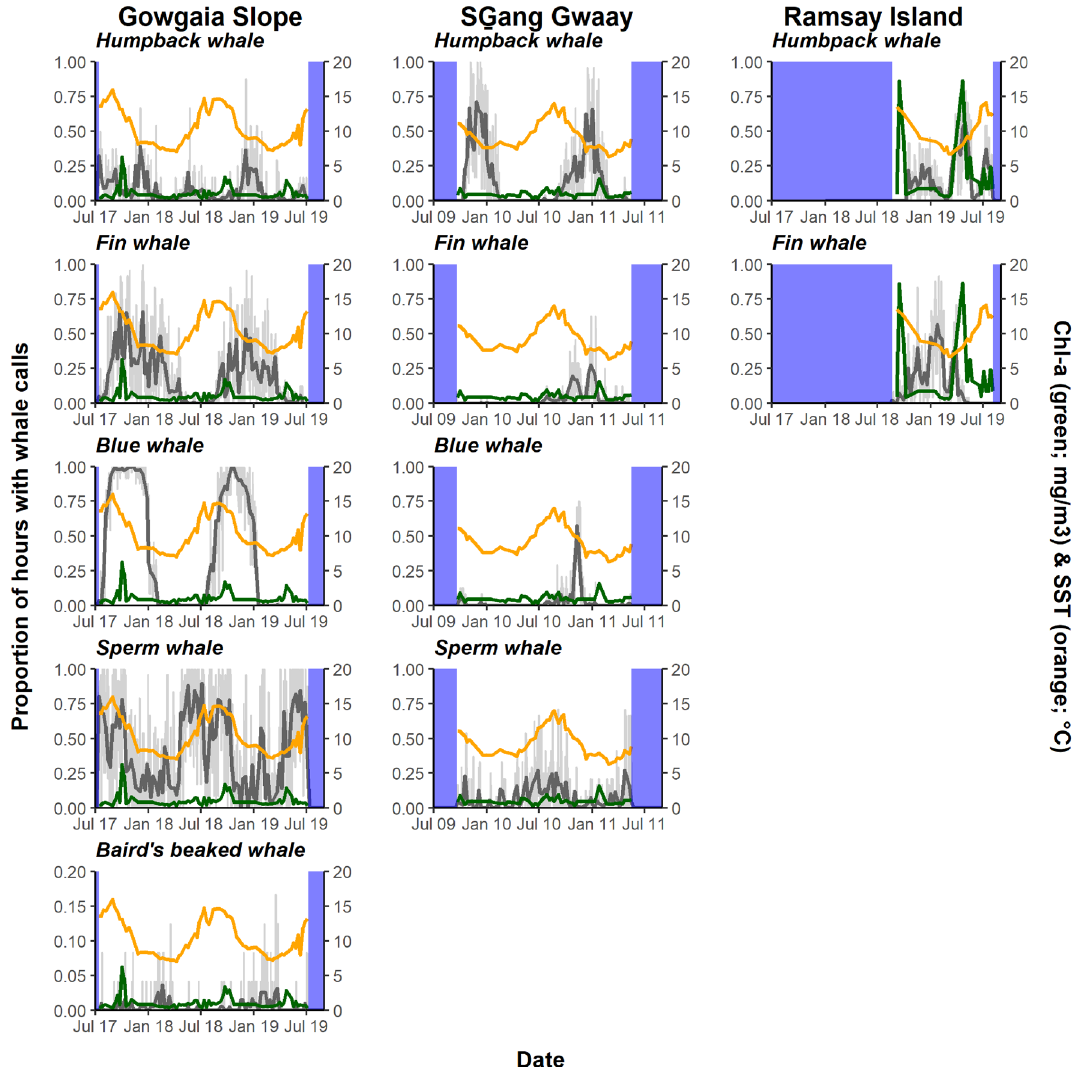
Figure 15. Time series of proportion of hours each day with calls for humpback, fin, blue, sperm, and Baird’s beaked whales (light grey line) and as an 8-day average (composite, dark grey line) over the deployment times for each hydrophone; chlorophyll a (chl-a, green line); and sea surface temperature (SST, orange line) at Gowgaia Slope, SGang Gwaay and/or Ramsay Island. Note that Baird’s beaked whales have a different y-axis scale due to the lower number of